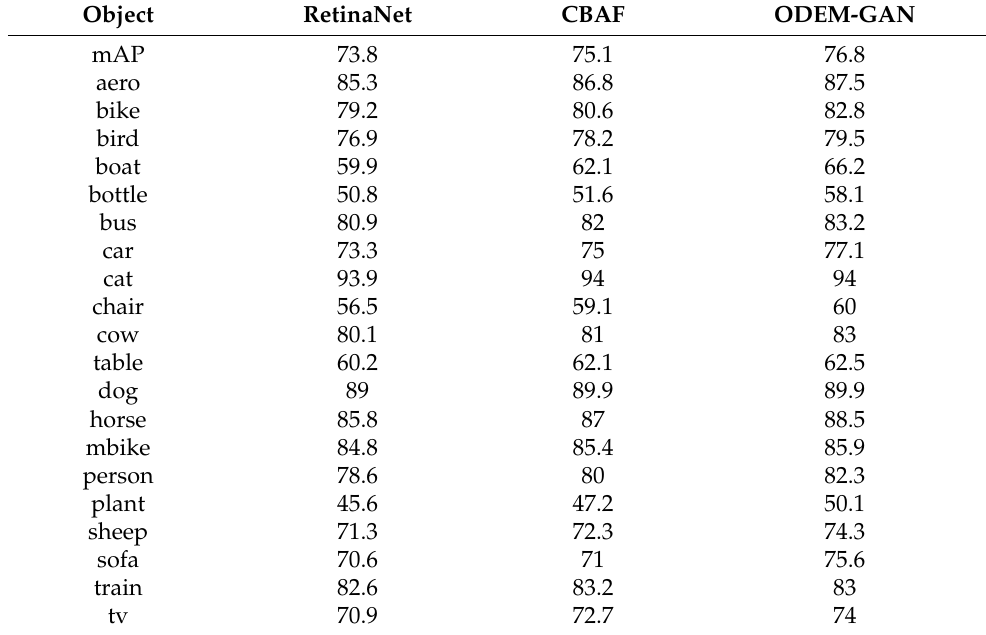
Table 7. The performance based on the AP score of the ODEM-GAN module for each category on the PASCAL VOC 2012